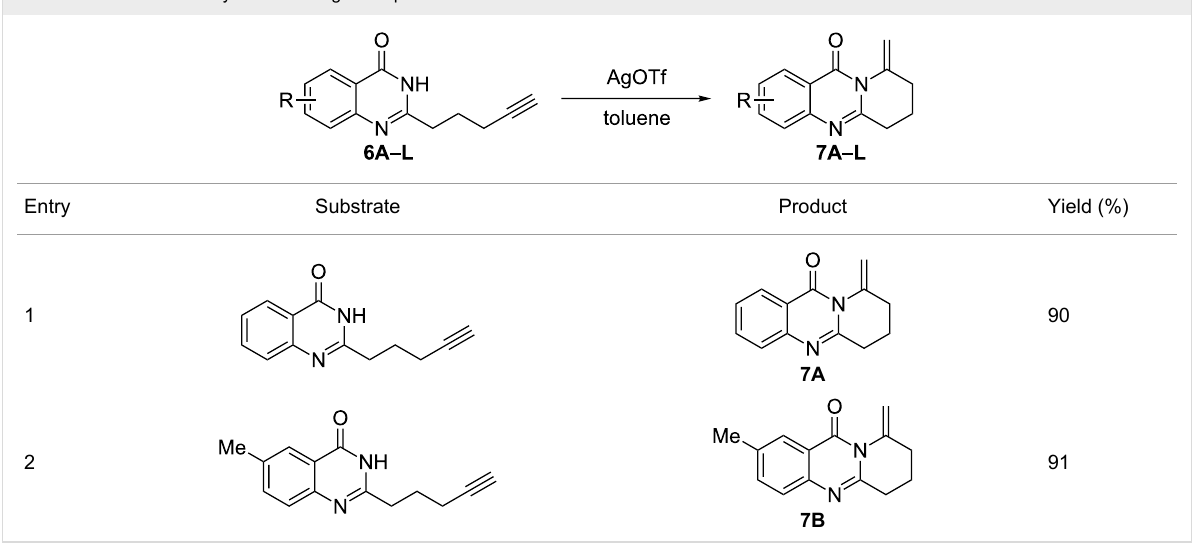
Table 2: Silver-mediated synthesis of target compounds 7A–L . a